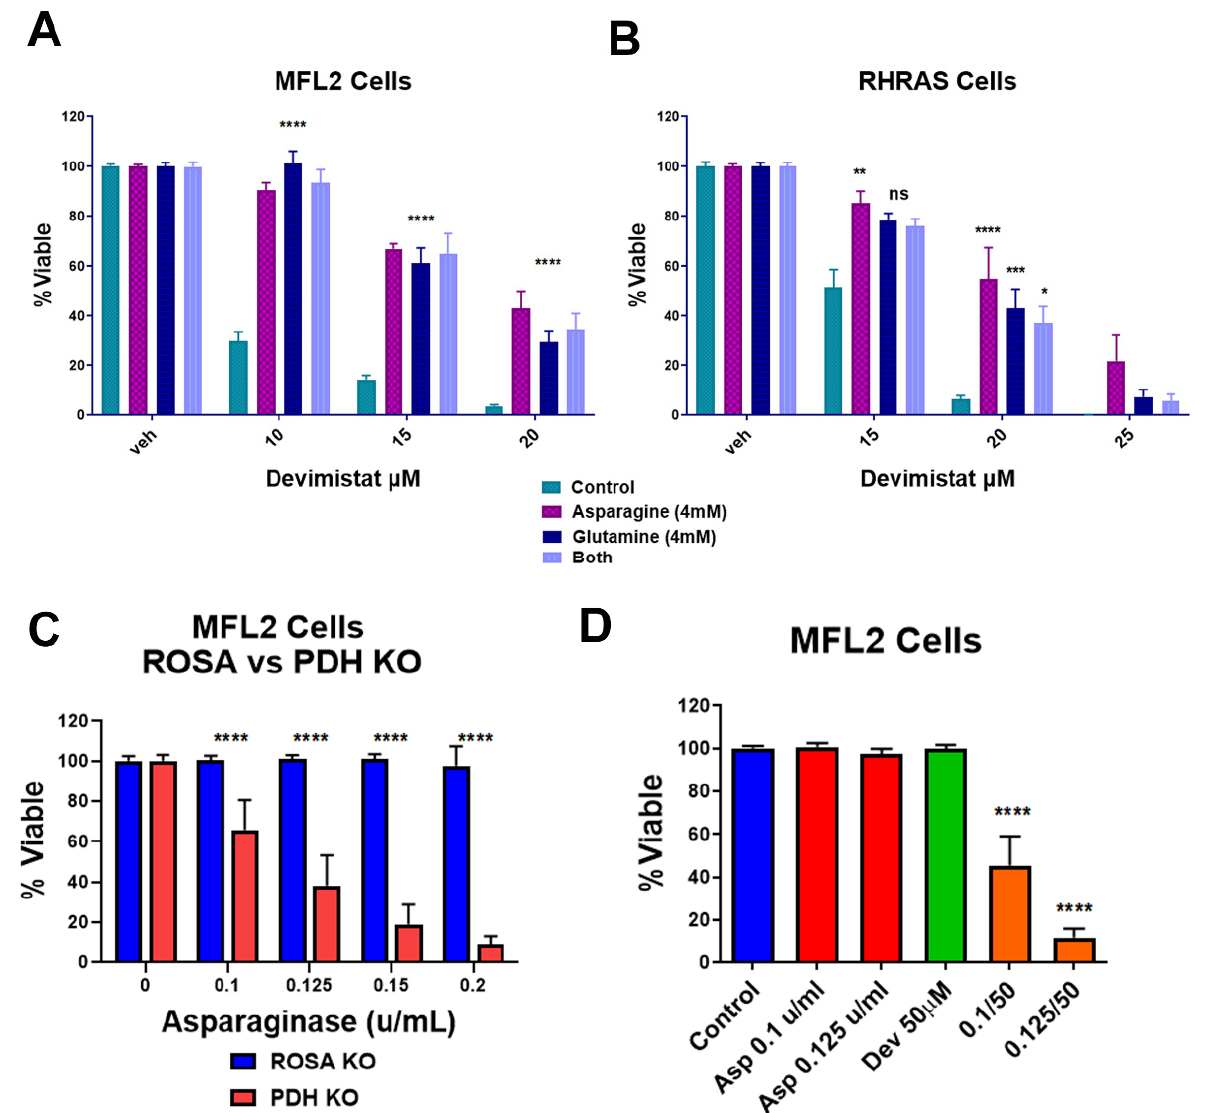
Figure 3. Asparagine and glutamine rescue AML cells from devimistat treatment. ( A ) MFL2 cells were incubated for 4 h in HBSS with 4 mM asparagine, 4 mM glutamine or both, with the indicated doses of devimistat. The cells were then washed and returned to complete media for 72 h and viability was assessed. ( B ) RHRAS cells were incubated for 4 h in HBSS with 4 mM asparagine, 4 mM glutamine or both, with the indicated doses of devimistat. The cells were then washed and returned to complete media for 72 h and viability was assessed. ( C ) ROSA and PDH KO MFL2 cells were incubated with the indicated concentration of asparaginase for 72 h and assessed for viability. ( D ) MFL2 cells were incubated with the indicated concentrations of devimistat, asparaginase or both for 72 h and assessed for viability. **** = p -value less than or equal to 0.0001; *** = p -value less than or equal to 0.001; ** = p -value less than or equal to 0.01; * = p -value less than or equal to 0.05. ns =